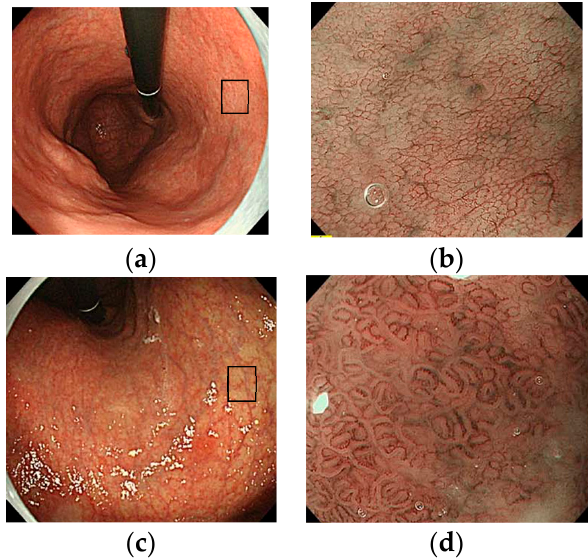
Figure 10. Magnifying NBI images of corpus mucosa with AIG. ( a , b ) Foveolar type; ( c , d ) groove type. The rates of foveolar type and groove type were 40% (17/43) and 37% (15/43), respectively, in our study [29].